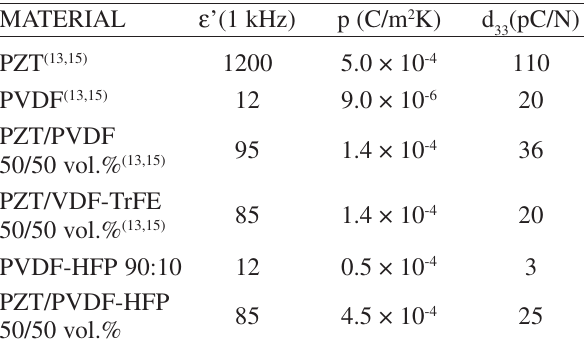
Figure 5. Pyroelectric coefficient as a function of temperature. Sample poled with E = 20 MV/m at 90 °C for 1.0 Table 1. Values of the permittivity and of the pyroelectric coeffi- cient of some materials.